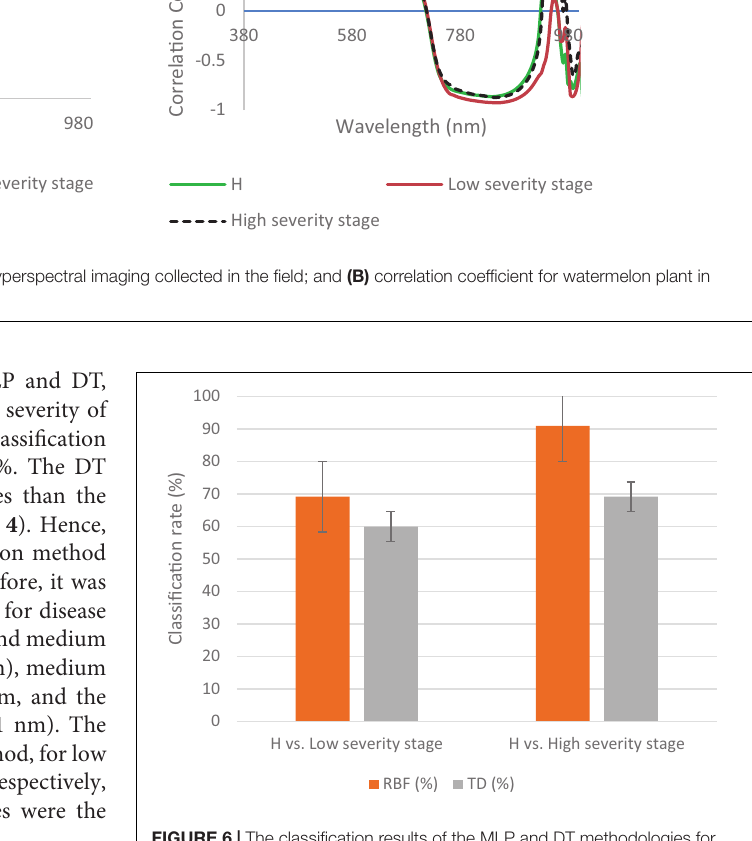
FIGURE 6 | The classification results of the MLP and DT methodologies for detecting several disease severity stages of downy mildew in watermelon plants in the field against healthy plants (H). The vertical lines on the columns are error